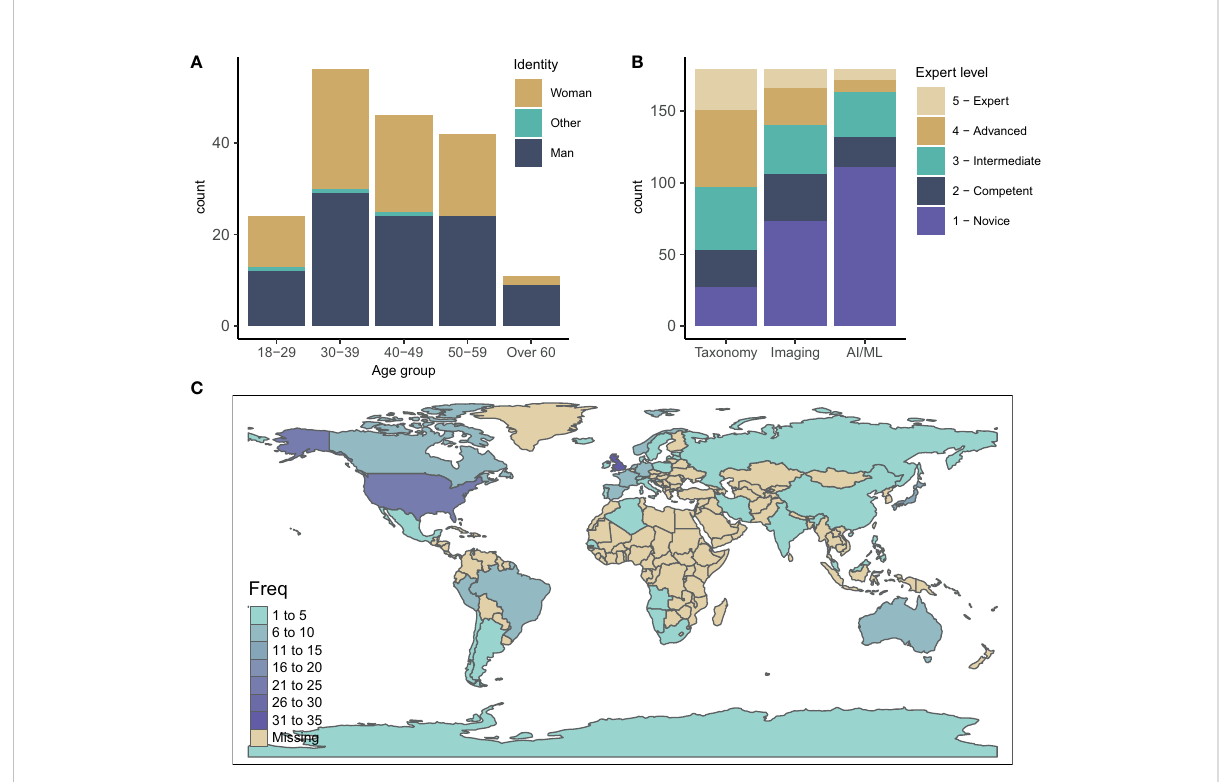
FIGURE 2 (A) Age and gender distribution of survey participants. (B) Expertise of participants in the three fi elds of zooplankton taxonomy, zooplankton imaging and AI/ML for zooplankton monitoring and research. (C) Geographic distribution of survey